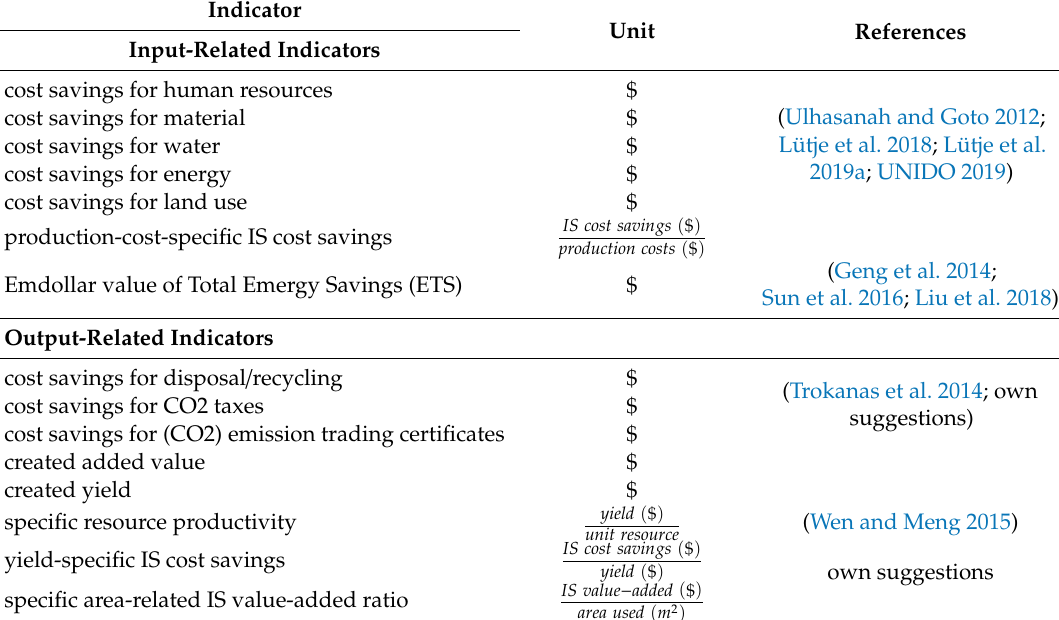
Table 5. IS economic indicator